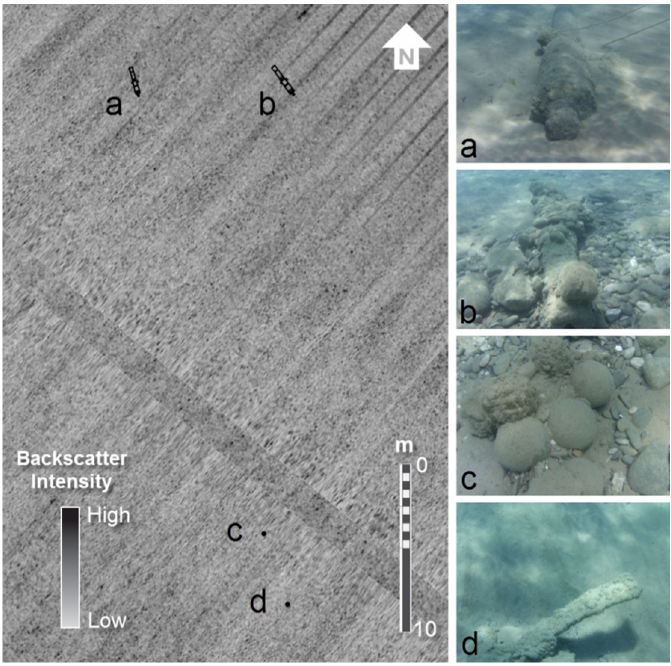
Figure 14. Backscatter intensity surface over wreck site 3. The seafloor is comprised of fine sand which covers archaeological assets that were exposed and precisely positioned on the seafloor in 2012 and are shown draped on the acoustic backscatter surface (( a , b ) cannons, ( c ) cannonballs, ( d ) unknown ferrous artefact).